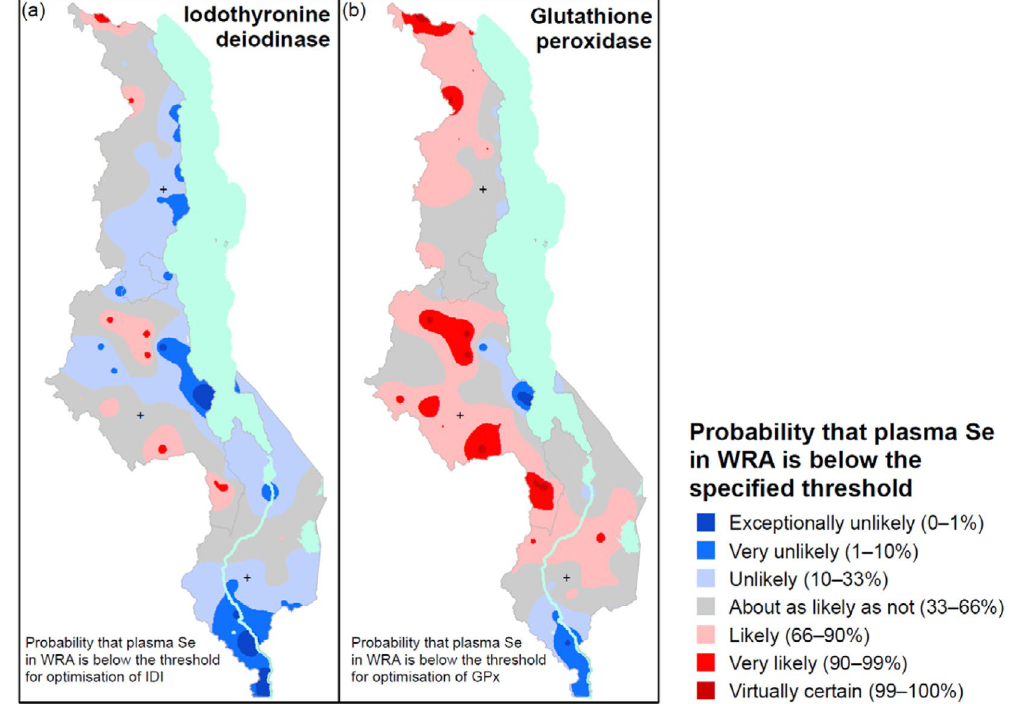
Figure 2. Probability that measured plasma selenium (Se) concentration of women of reproductive age (WRA) would fall below the threshold for the optimal activity of ( a ) iodothyronine deiodinase (IDI), ( b ) glutathione peroxidase 3 (GPx3). The legend units are defined verbally, and by a range of probability values, expressed as